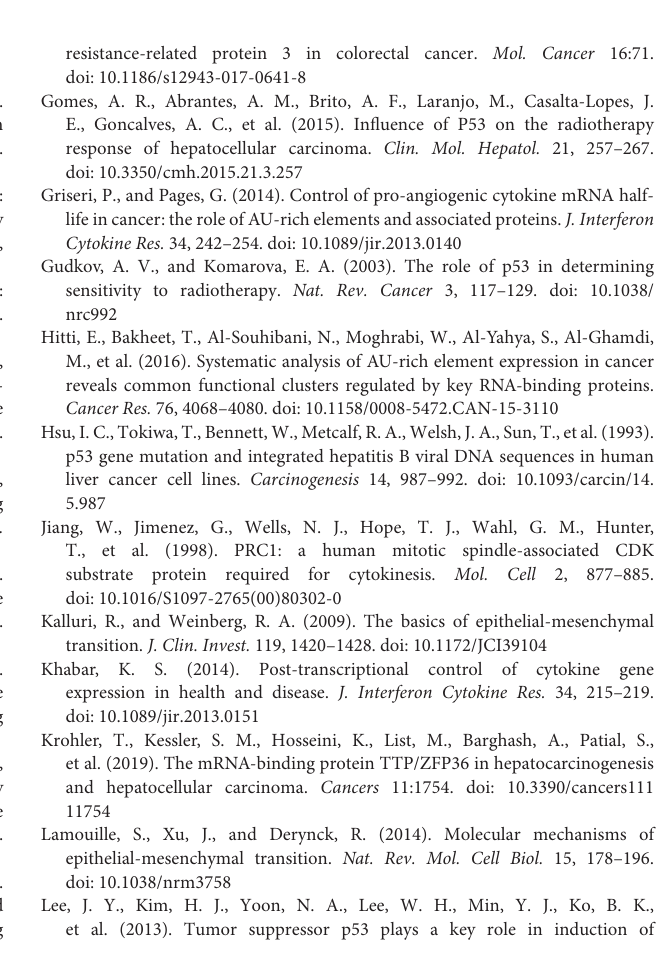
Supplementary Figure 1 | PRC1 is upregulated in liver cancer tissues. (A) Expression levels of PRC1 protein in tissue microarrays (TMAs, 68 paired liver cancer tissues and 60 paired adjacent non-tumor tissues) were determined by immunohistochemistry (IHC). Representative examples of PRC1 staining in cancer tissues and non-tumoral tissues are shown. (B) Kaplan–Meier analysis of the relationship between PRC1 expression and survival of hepatocellular carcinoma patients ( ∗ p < 0.041, Log-rank